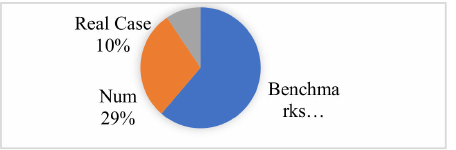
Figure 27. Percentage of different types of case studies in the